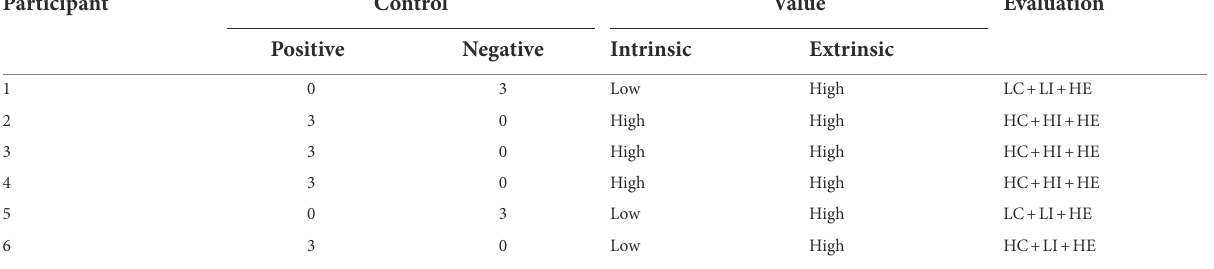
TABLE 1 Participants’ control-value appraisals.